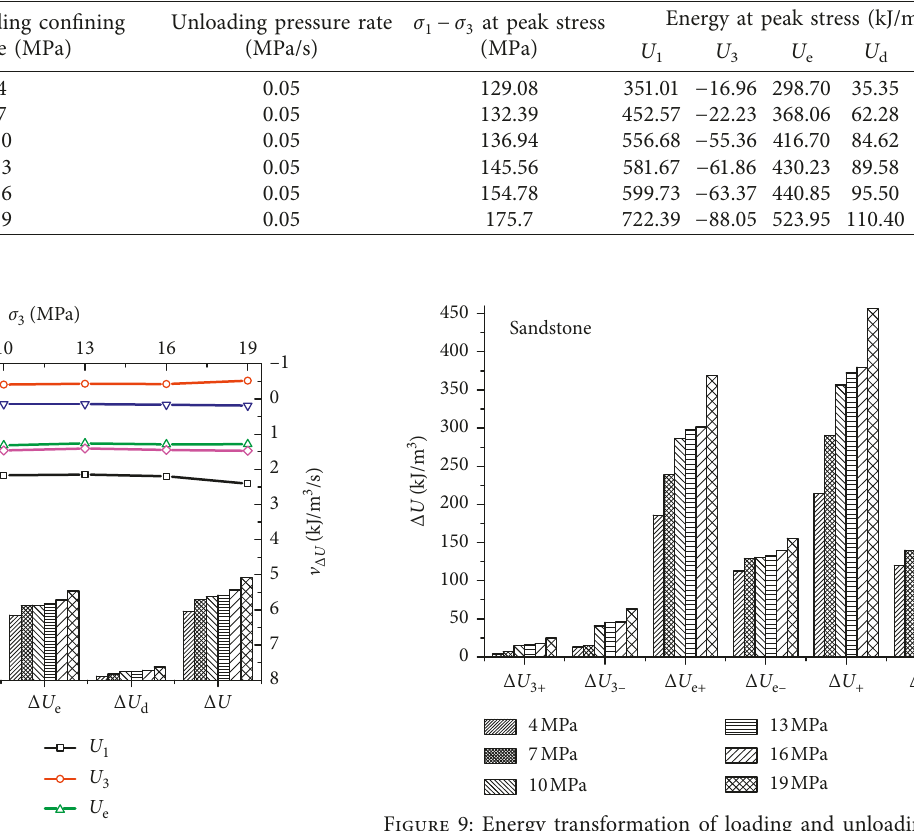
Table 1: Energy levels at peak stress under different initial unloading confining